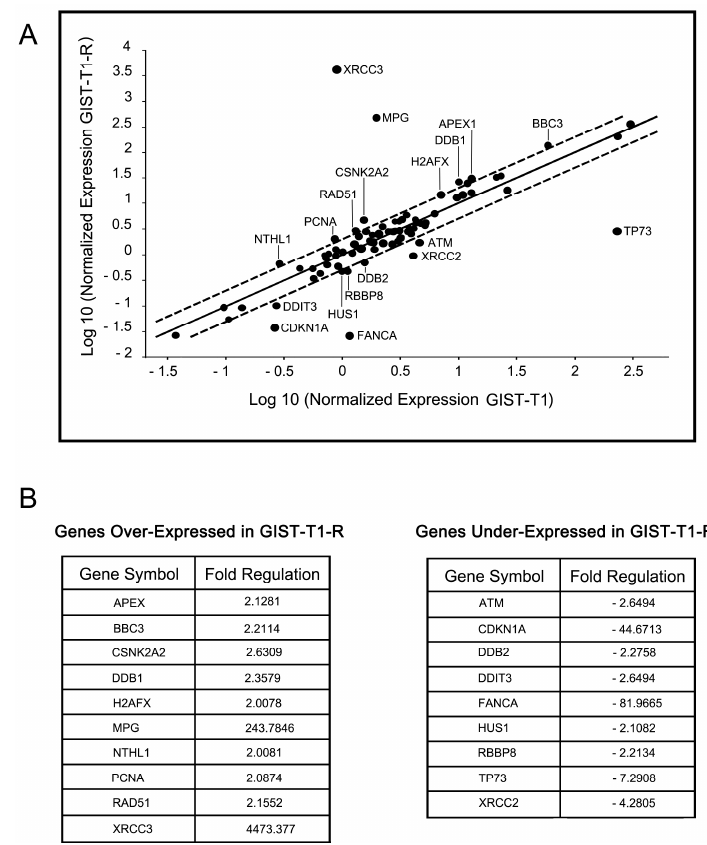
Figure 7. DNA damage repair (DDR) profile in GIST T-1R cells. ( A ) Relative expression comparison for 84 DDR-related genes between IM-resistant GIST T-1R (x-axis) and IM-sensitive parental GIST T-1 cells (y-axis). MPG, XRCC3 and CSNK2A2 genes were upregulated, while CDKN1A, FANCA, TP73 and XRCC2 were downregulated, by at least two-fold (outside the outer line) in GIST T-1R cells relative to the parental GIST T-1 cell line. Three genes ( β 2-microglobulin, β -actin and glyceraldehyde-3-phosphate dehydrogenase) were used for data normalization. ( B ) Changes in expression for DDR and cell cycle-related genes between IM-sensitive GIST T-1 and IM-resistant GIST T-1R cells. Genes from the experiment in Figure 6A that exhibited a two-fold or greater change in expression between GIST T-1 and GIST T-1R cells are presented.